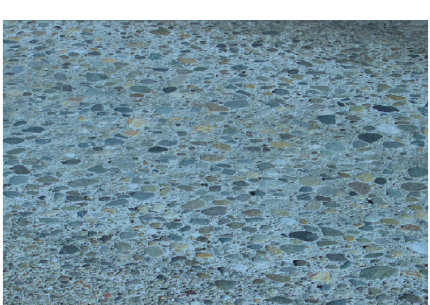
Figure 4: Surface polishing